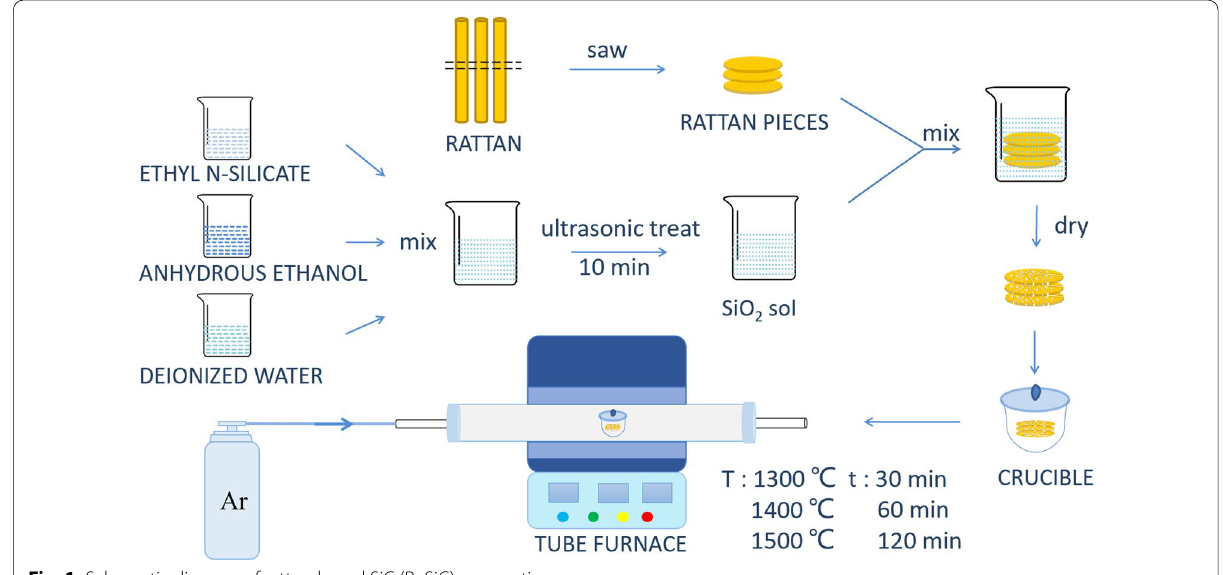
Fig. 1 Schematic diagram of rattan-based SiC (R–SiC) preparation process